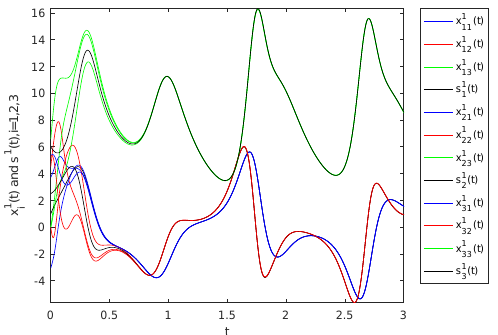
( 1 ) ( t ) and s ( 1 ) ( t ) under Controller (4). ı